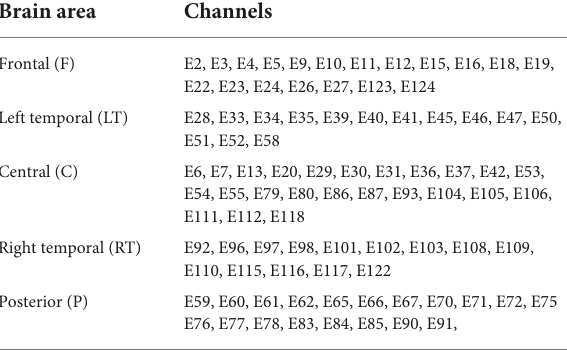
TABLE 3 Brain regions corresponding to channels of